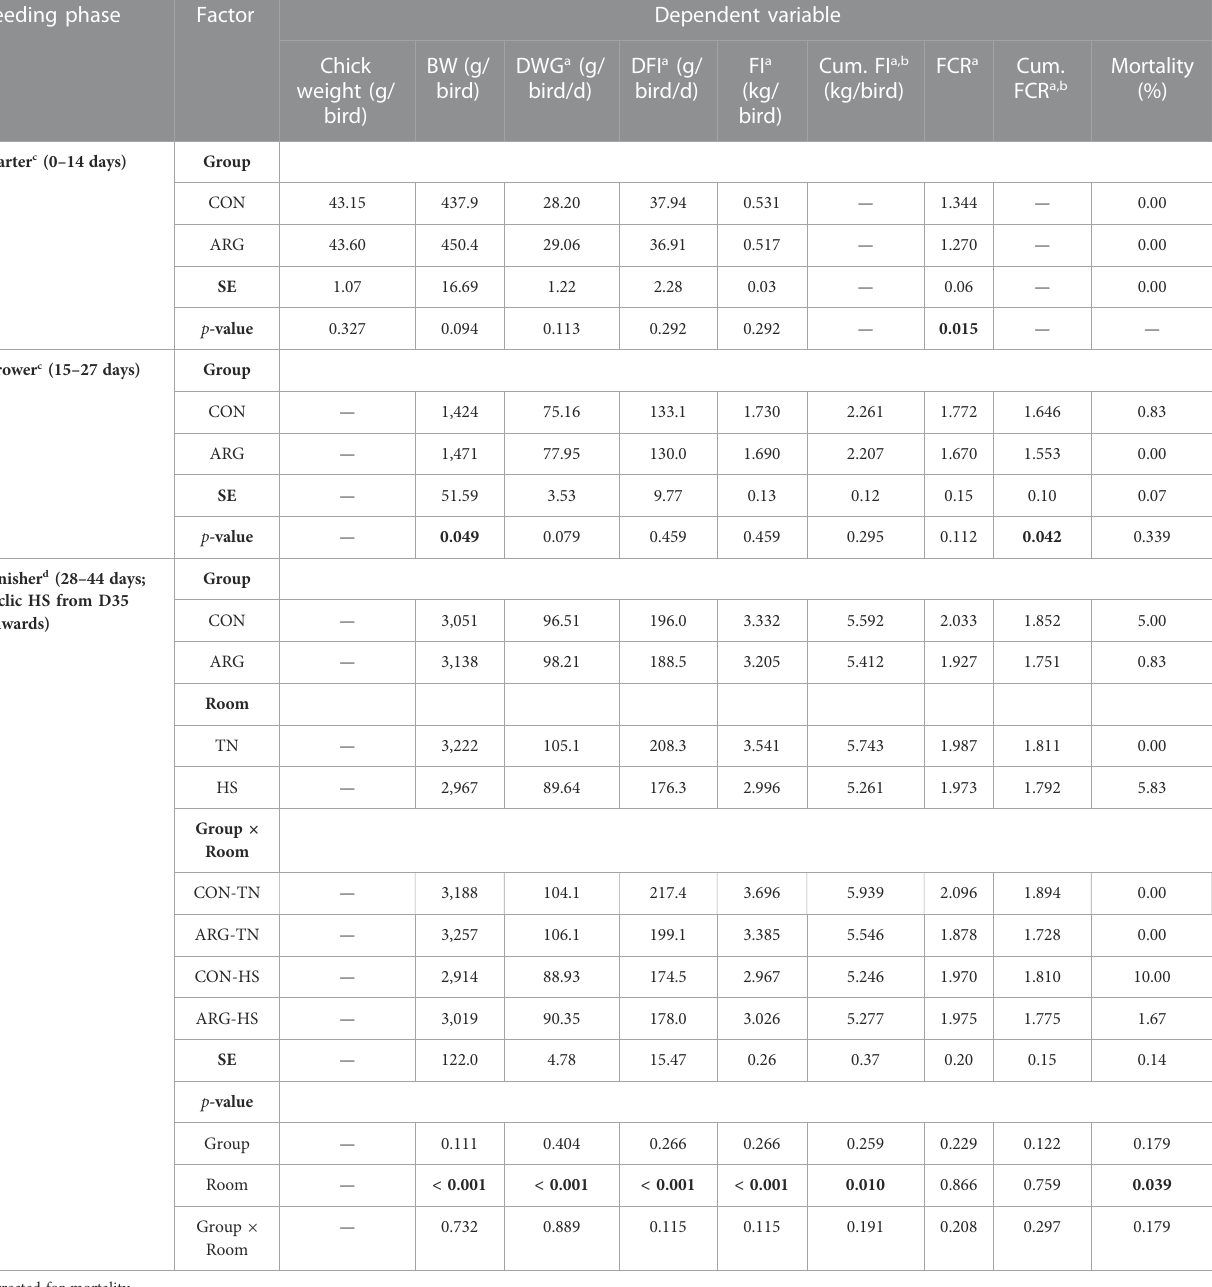
TABLE 2 Growth performance of groups CON and ARG in the three-phase feeding trial. Feeding